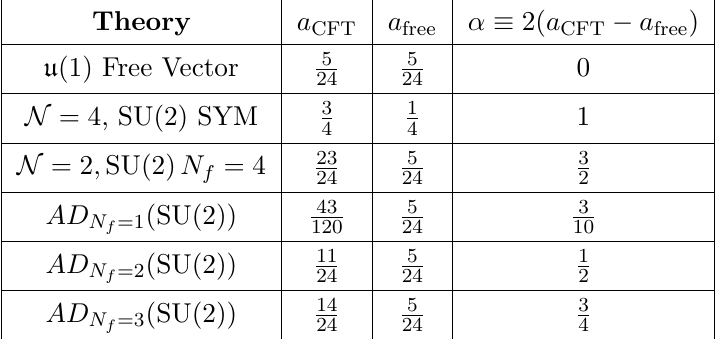
Table 1 . A list of values for the coefficient α of the Wess-Zumino term in the effective the- ory for the conformal symmetry breaking dilaton. On the last three rows we use the notation (SU(2)) to denote the Argyres-Douglas IR superconformal fixed point realized from AD N f =1 , 2 , 3